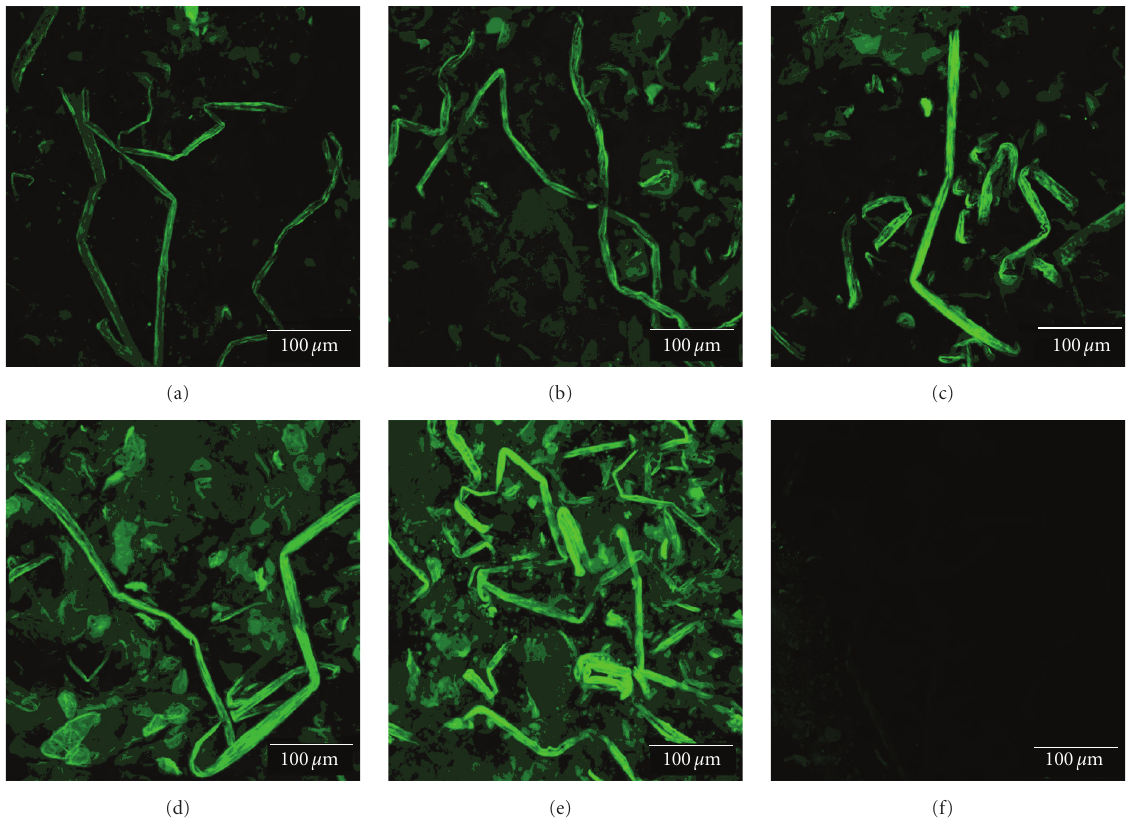
Figure 6: Peptide conformations of various sizes of FITC-labeled FSCPs in nude mice skins. Nude mice skins were treated with various molecular sizes of FITC-labeled FSCPs in the Franz-type di ff usion cell model. The topical sites of tested nude mice skins were collected in one hour. The vertical cross-sections of the nude mice skins were imaged for FITC signals using cryosection and confocal spectral microscope systems. (a) 1,300 Da FSCPs; (b) 2,000 Da FSCPs; (c) 3,500 Da FSCPs; (d) 4,500 Da FSCPs; and (e) the mixture FSCPs (FSCPs without ultracentrifugation membrane